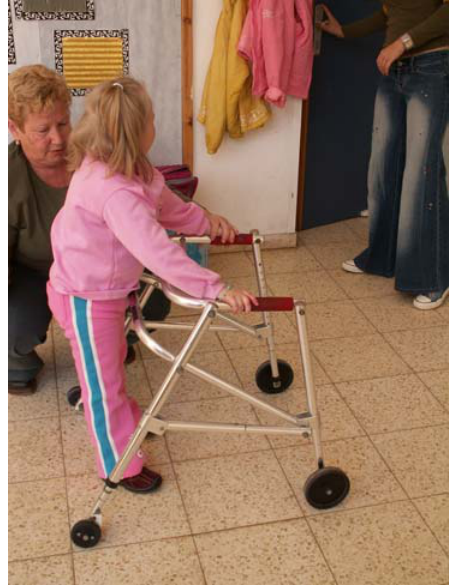
PICTURE 22 . Non-conventional use of a posterior